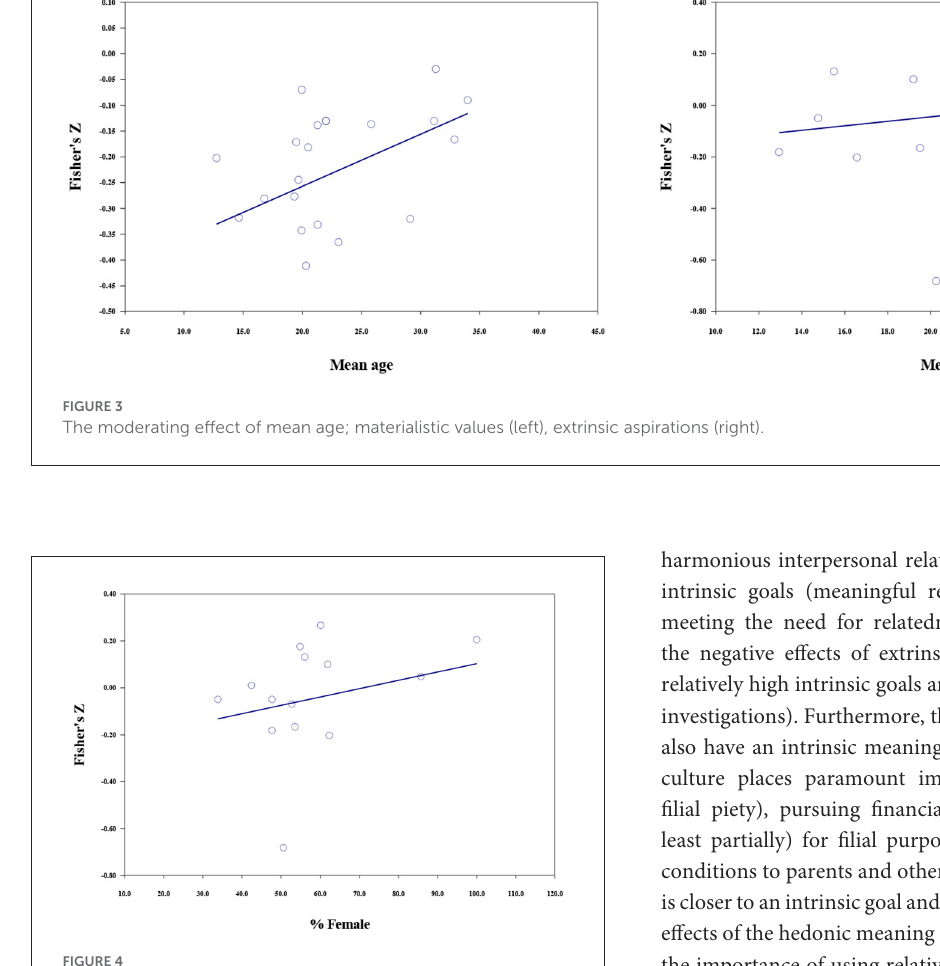
FIGURE4 The moderating role of percent female in the association between extrinsic aspirations and subjective